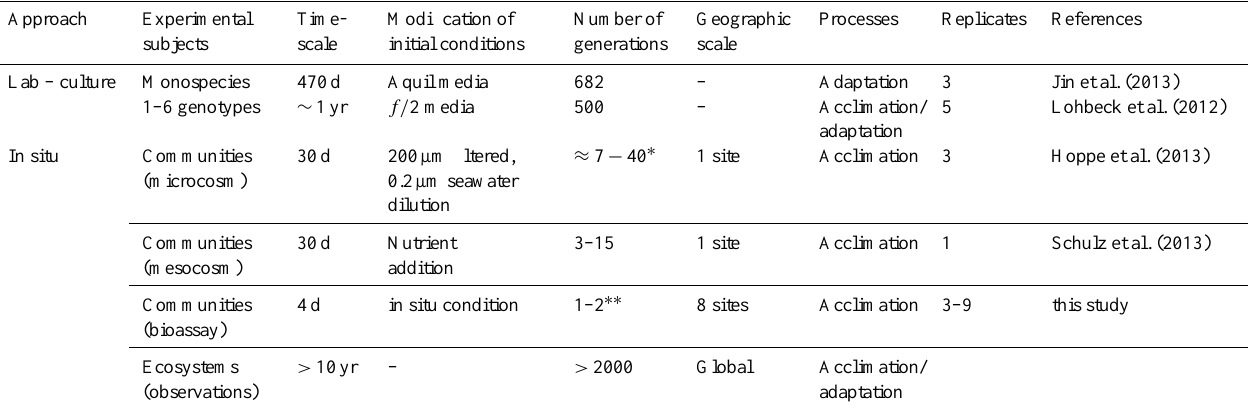
Table 1. Environmental relevance versus experimental power. For each approach, an example of the study involving the longest incubation period is listed.